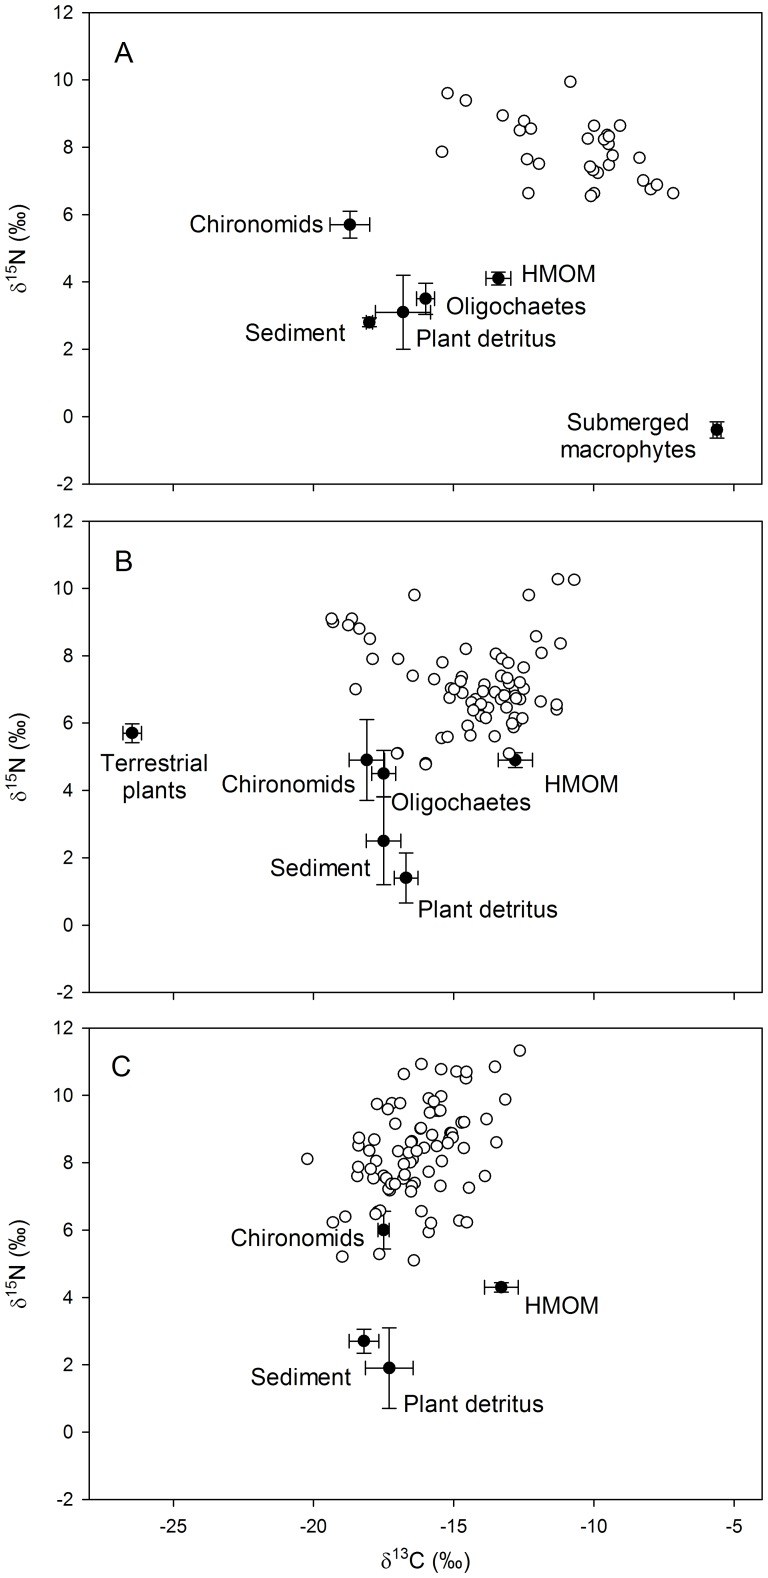
Stable isotope bi-plots of the Lake Naivasha food web derived from samples collected during July in A) 2001, B) 2002, and C) 2003.Open symbols represent individual Procambarus clarkii relative to the putative basal resources (solid symbols: means ±SE from n = 5 to 15) which were present and sufficiently abundant during collection to be analysed for stable isotopes. HMOM – Hippo Mediated Organic Matter.